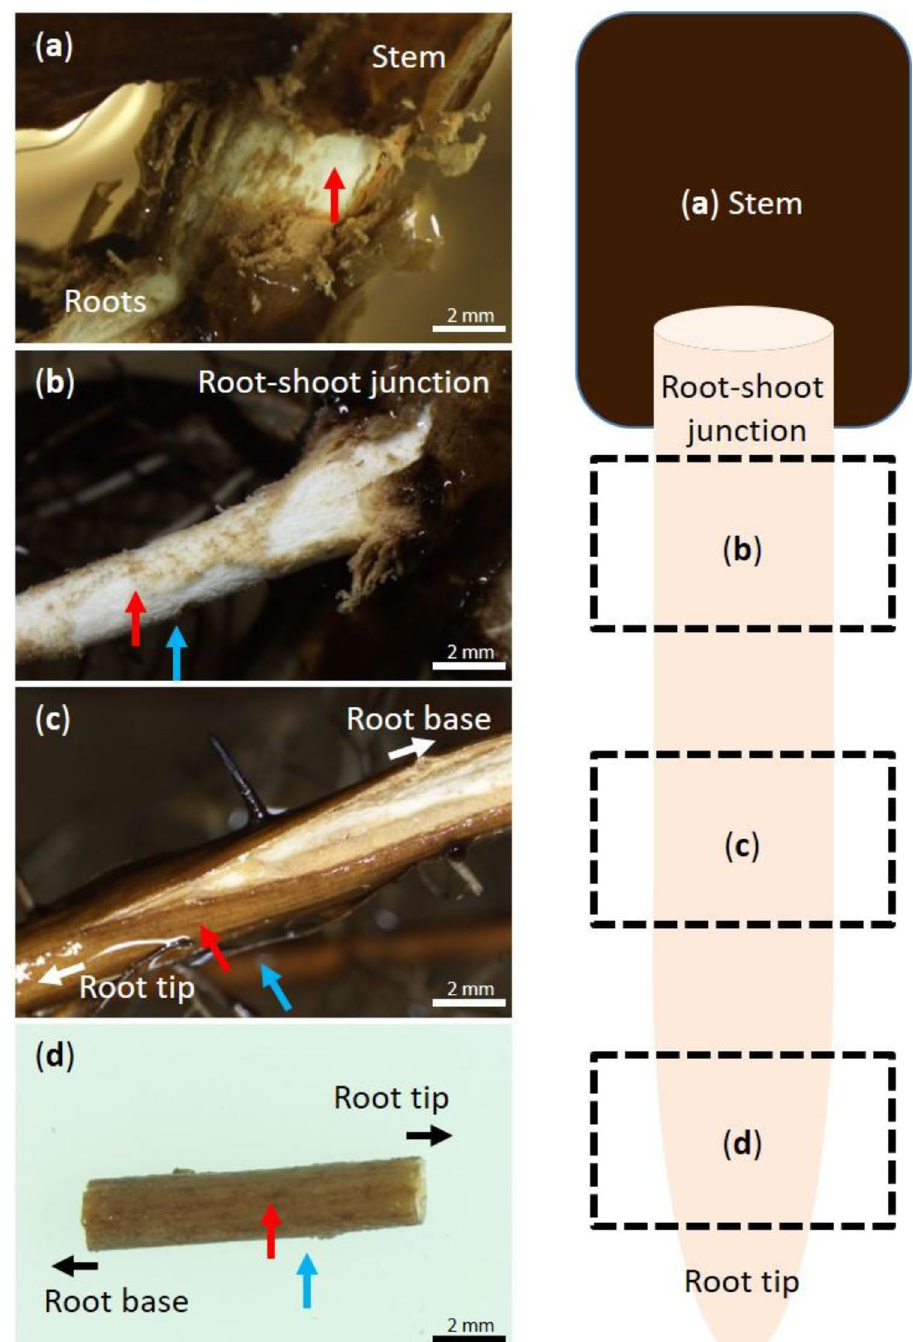
Figure 3. Measurement of oxygen concentration in primary and secondary aerenchyma in stems and adventitious roots after 150 days of hypoxic treatment. The red and blue arrow in each panel indicate the measurement point for the aerenchyma and rhizosphere, respectively. The red arrows indicate the secondary aerenchyma that developed in the ( a ) stem, ( b ) the measurement points of secondary aerenchyma in the root base where the cortex was removed, or ( c ) the primary aerenchyma in the root where cortex collapse had occurred. ( d ) Primary aerenchyma in the root 15 cm from the root-shoot